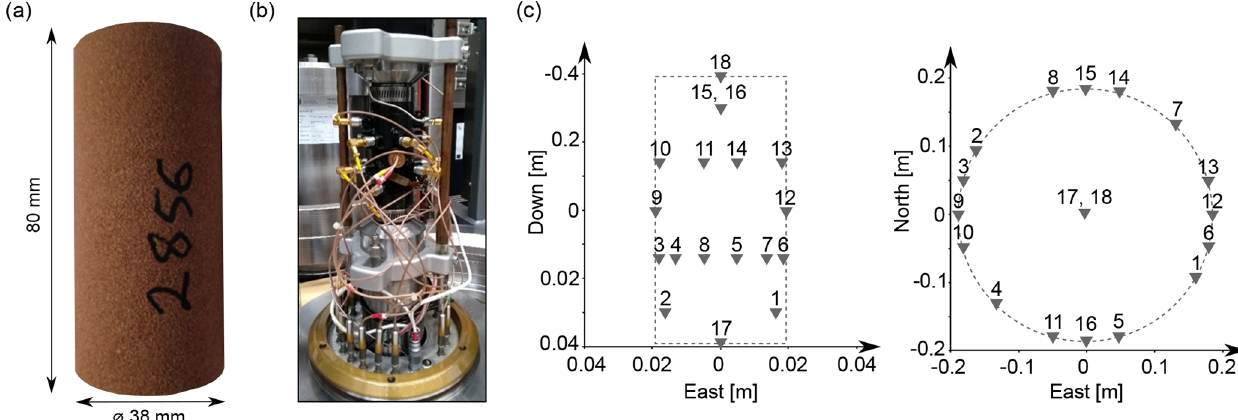
Figure 1. Testing material and experimental setup. (a) the Red Wildmoor sandstone sample, (b) the sample within the triaxial cell at CSIRO Energy, Perth, Australia, and (c) a map of the transducers locations: Sensors 1–8, 10, 11, 13–16 (14 sensors in total) were used for acoustic emission monitoring. Sensors 17 and 18 were used to determine P-wave velocities in the axial direction, and sensors 9 and 12 in the radial